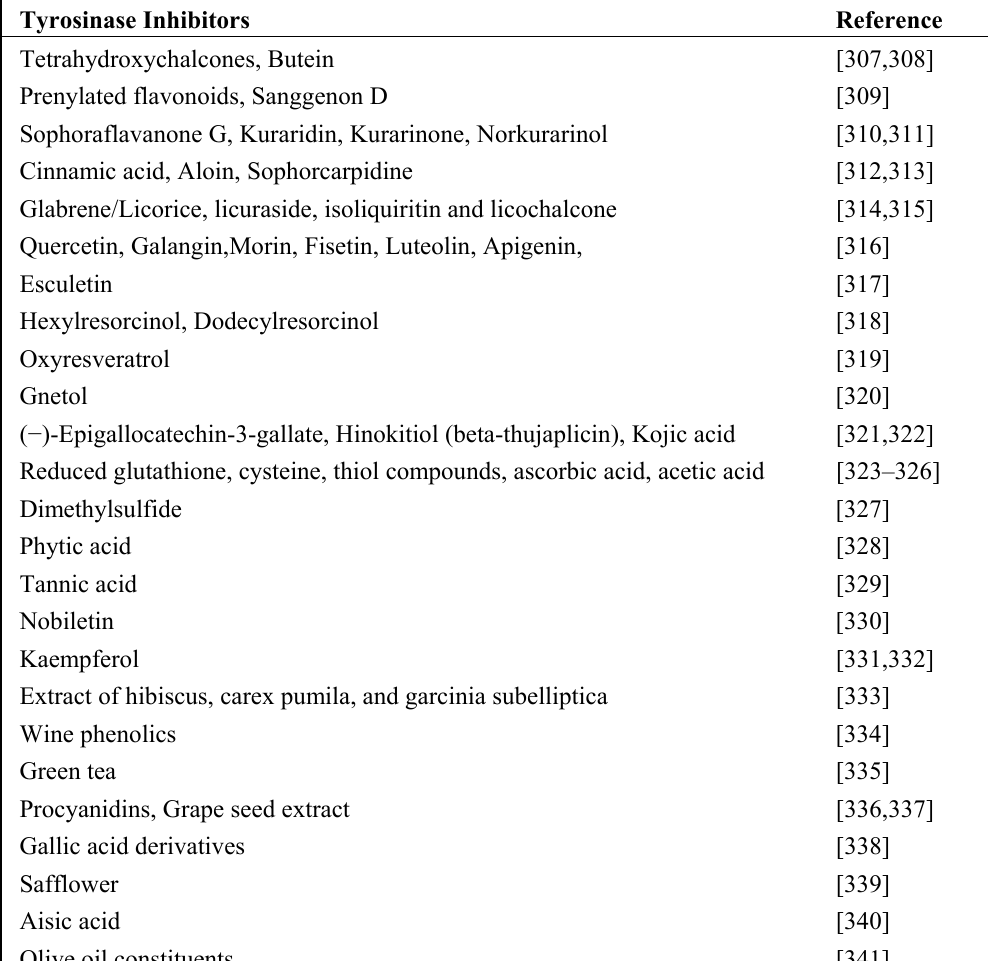
Table 1. Tyrosinase Inhibitors.